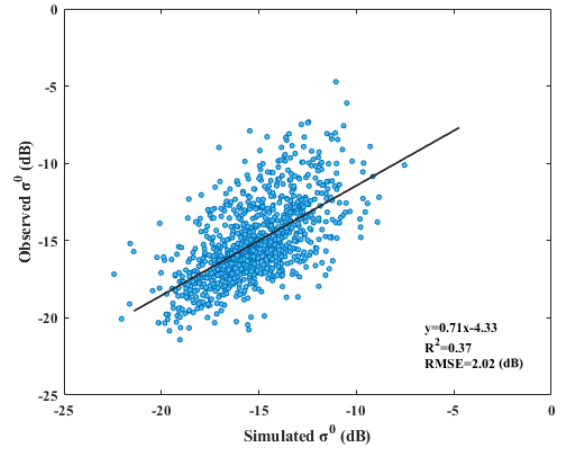
Figure 7. Comparison between measured and simulated SAR backscattering coefficients using the optimized surface RMSH.